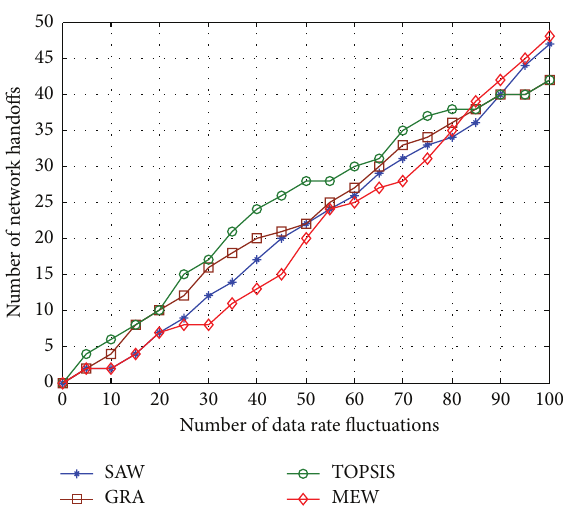
Figure 7: Network handoffs in case of weight 2.